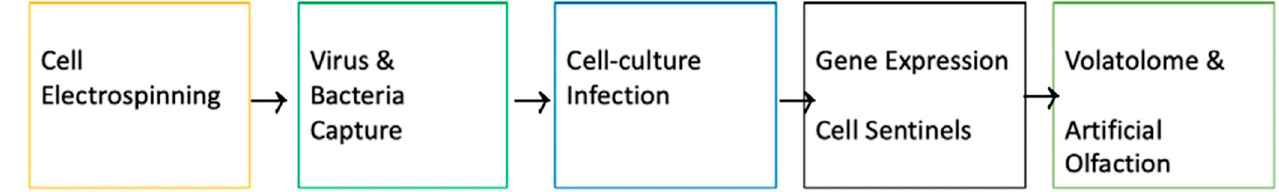
Figure 1. The main themes addressed in this perspective span across disciplines from sensors to immunology and from nano-bio-manufacturing to ethics.